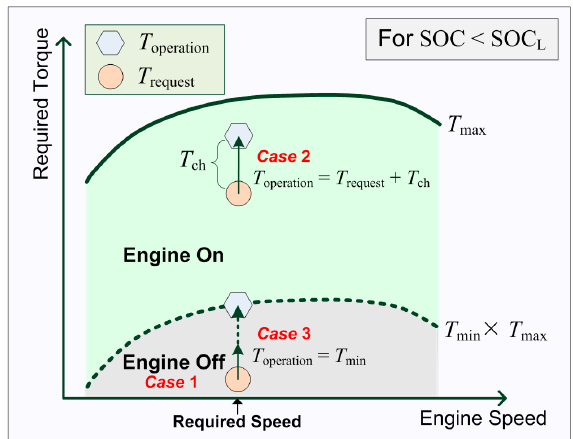
Figure 4. EACS for low SOC. Figure 3. EACS for low